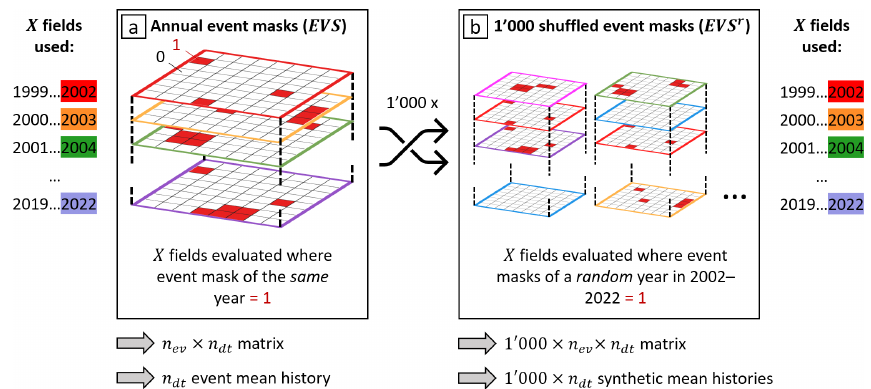
Figure B1. Schematic of the construction of the event mean meteorological histories (a) of event set EVS and (b) of their synthetic analogues EVS r used for the bootstrapping test. The rows on the side show the order in which fields of X are used to extract the time series for EVS and each EVS r . The annual binary event masks of EVS in (a) are colored according to the year of occurrence. The shuffled EVS r sets have a different order of these masks; however, they use the X fields in the same order as EVS.